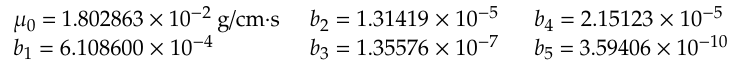
Table 2. Viscosity estimation coe ffi